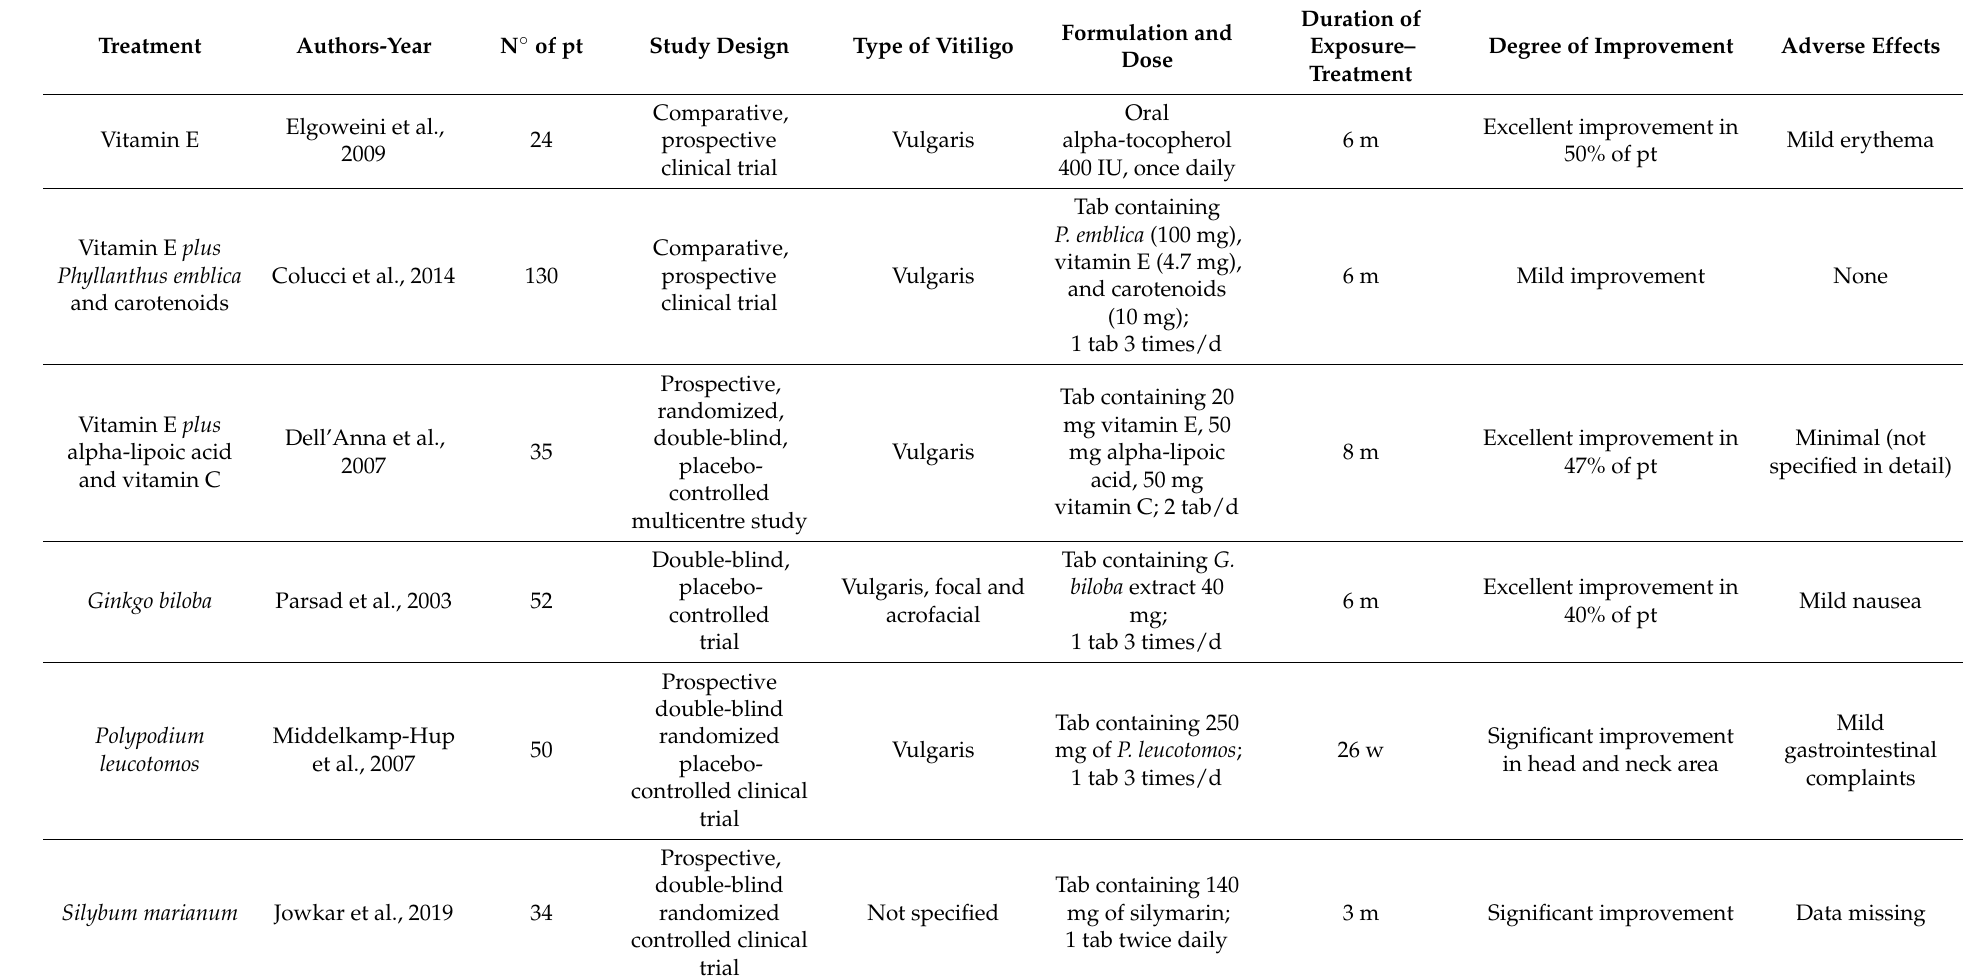
Table 2. Summary of studies on the efficacy of treatments with antioxidant potential in